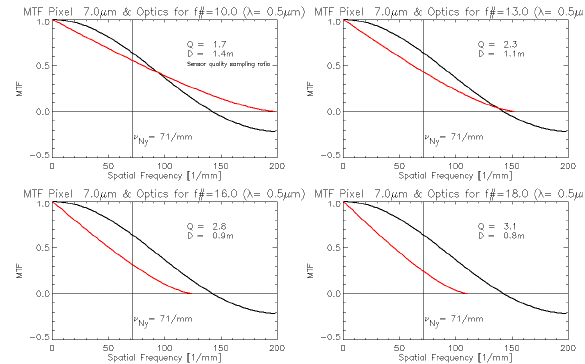
Figure 1: Relation between detector ( 7 µm ) and optics (red) MTF.